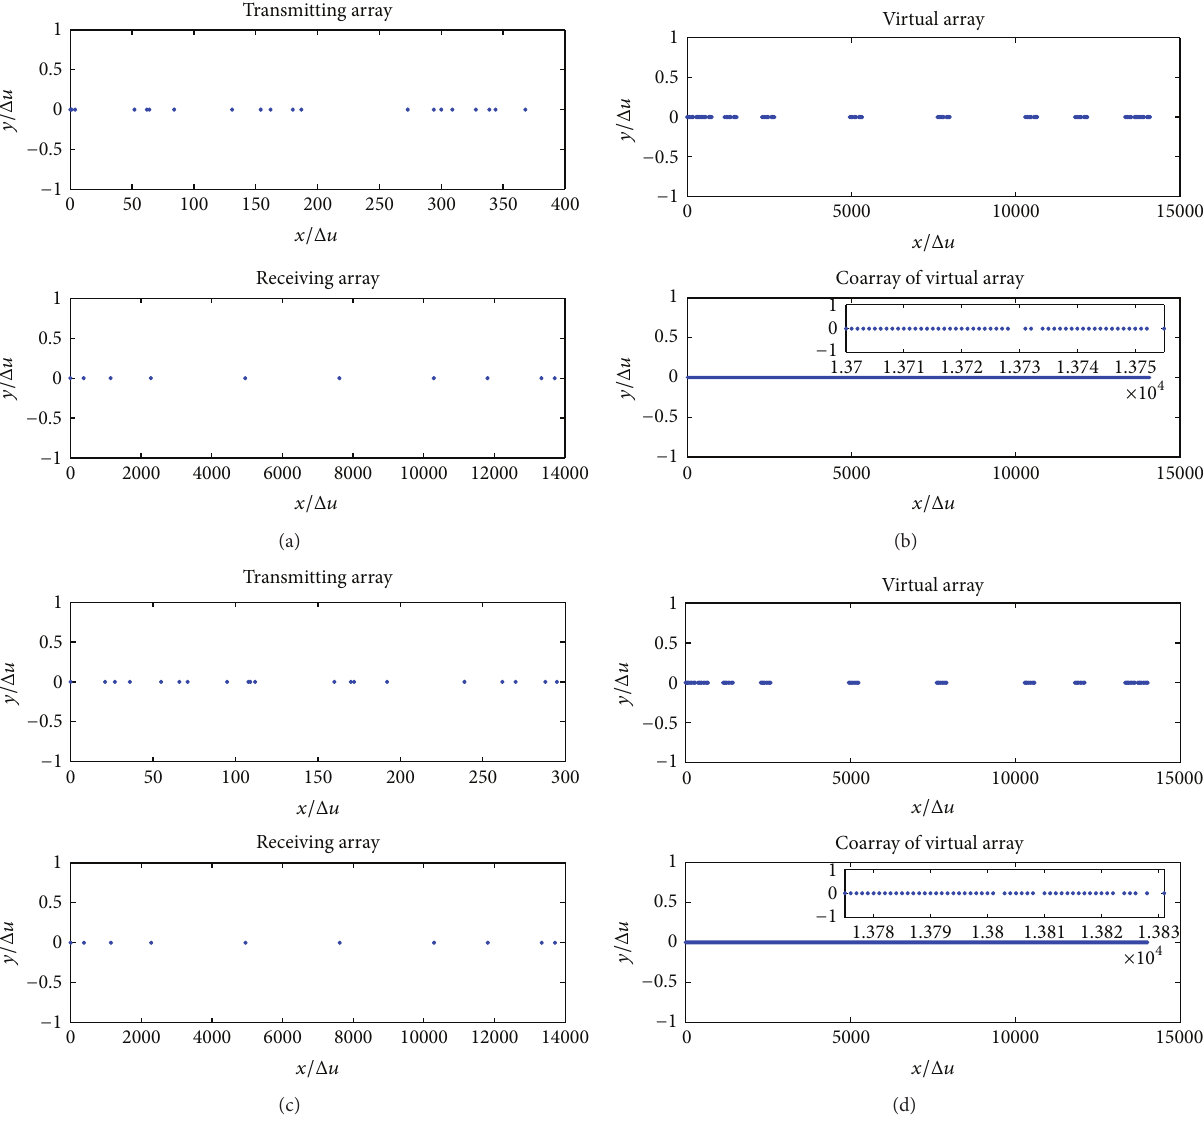
where 𝐷(381, 20, 1) = {0, 1, 4, 52, 62, 64, 84, 131, 154,